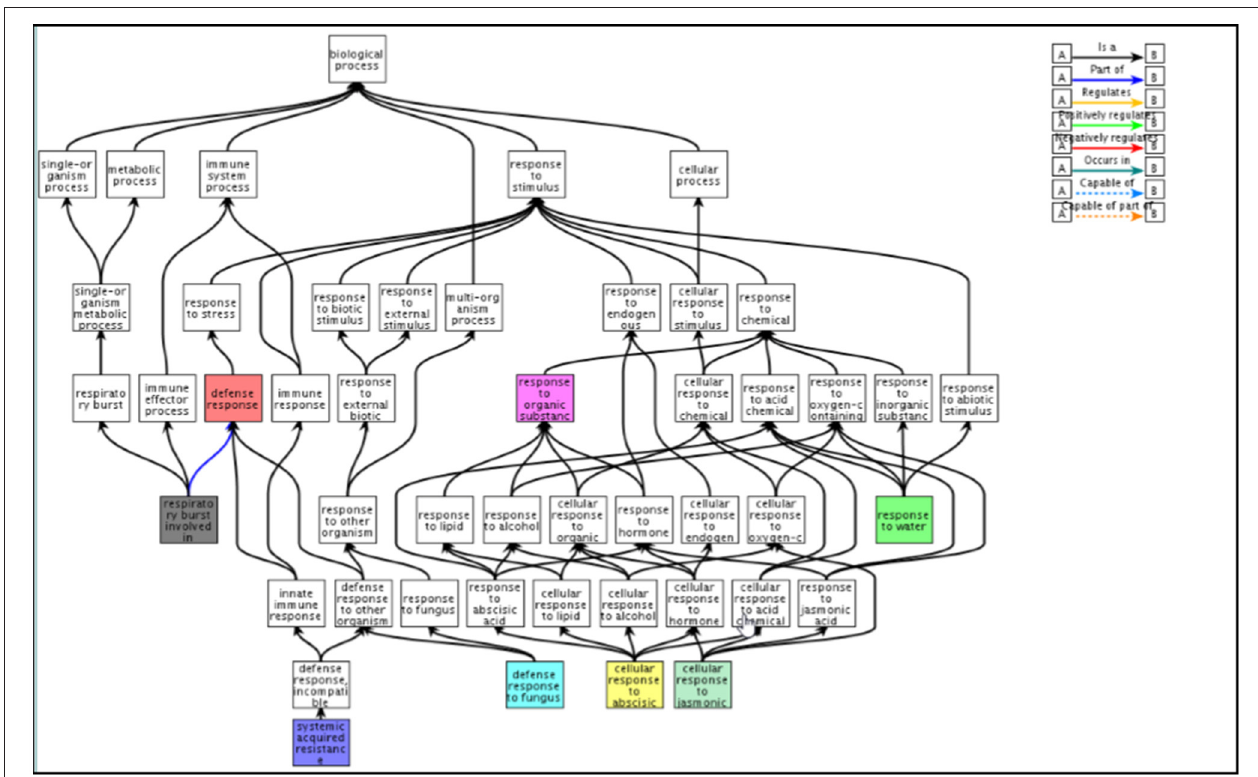
FIGURE 6 | Functional classification of gene clusters displaying reduced expression with CK treatment under salinity stress. QuickGo representation of down-regulated Gene Ontology groups identified by the enrichment analysis of the RNA sequencing data. Clusters were characterized by upregulation of gene expression under salinity which was attenuated with CK (clusters 1,3,4). The functional classification was performed with the QuickGo platform https://www.ebi.ac.uk/